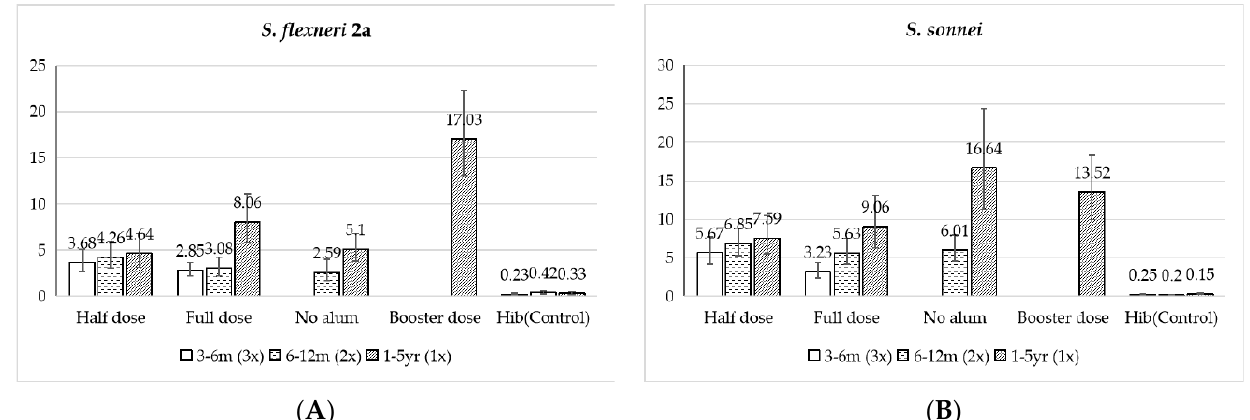
Figure 4. Composite chart of GMC anti ‐ LPS IgG. ( A ) S. flexneri 2a, ( B ) S.